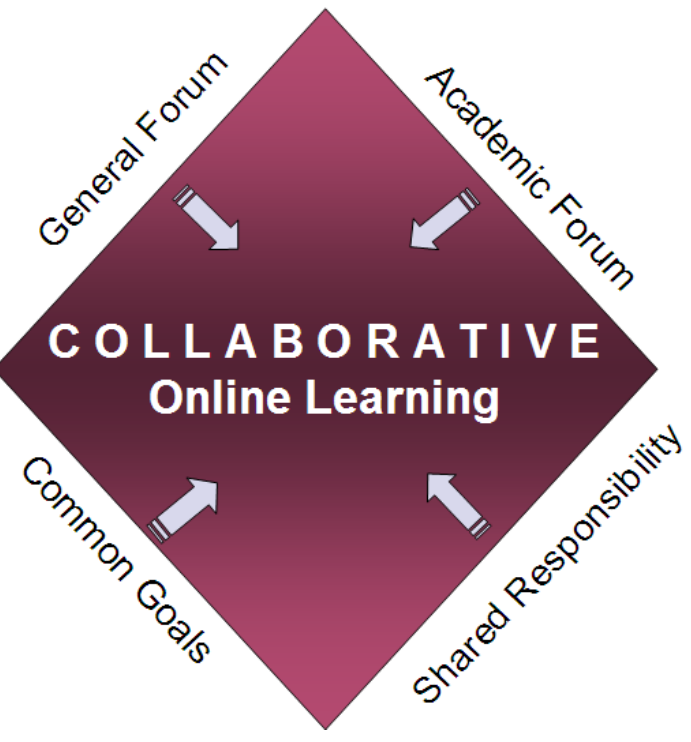
Figure 3. The Collaborative Online Learning